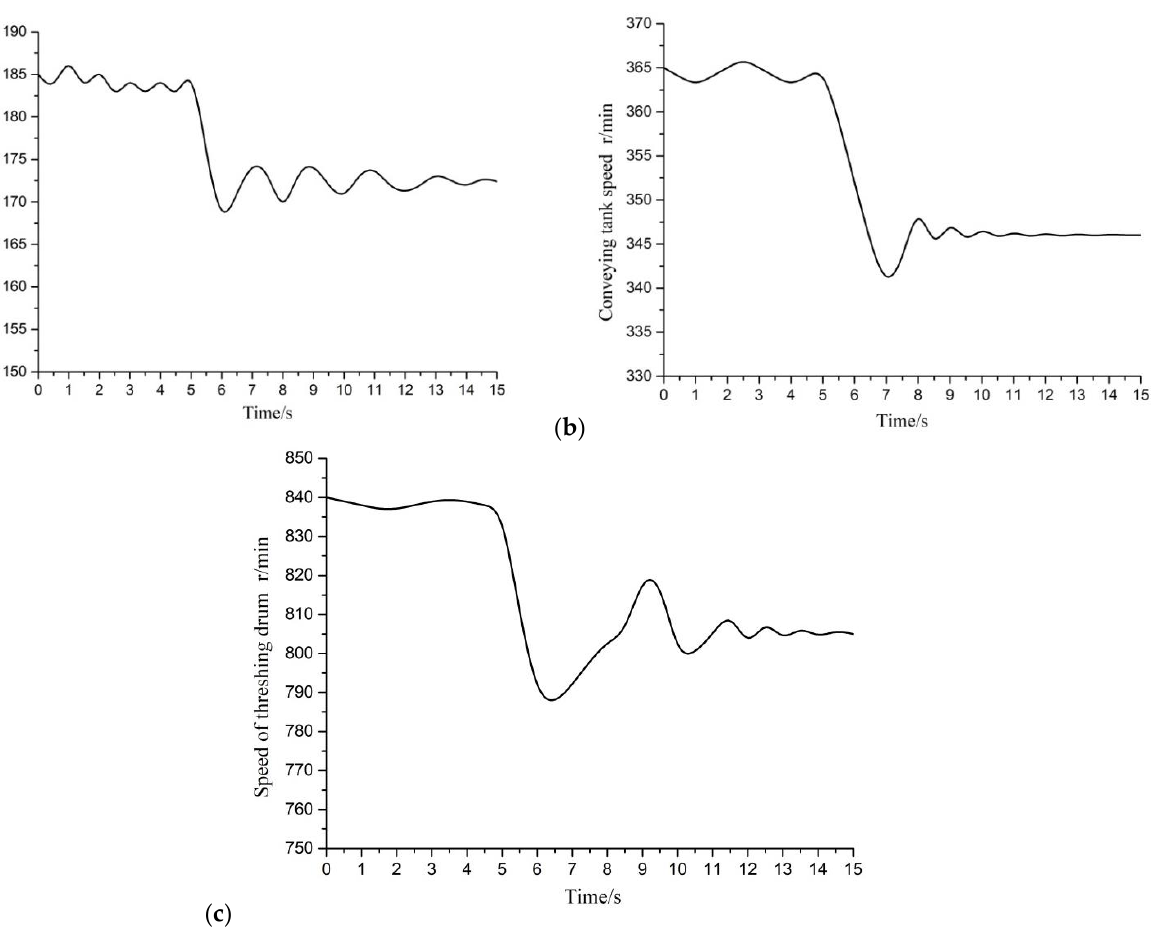
Figure 13. The relationship curve of rotation speed and time of the threshing drum, conveying trough and cutting table screw conveyer. ( a ) Speed of auger, ( b ) speed of conveyor, ( c ) speed of threshing drum.